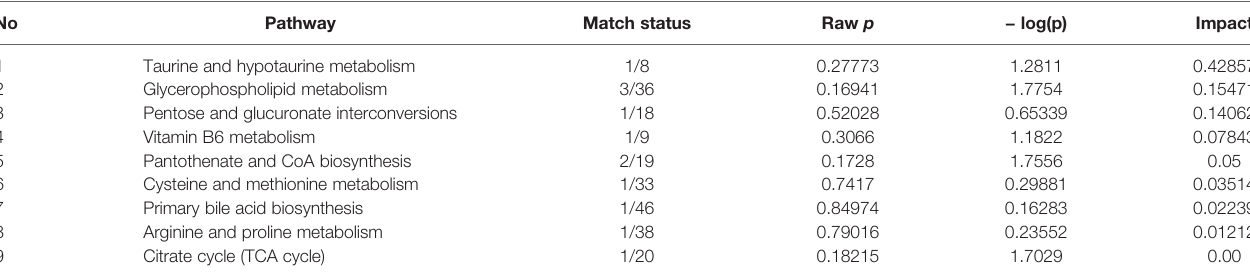
TABLE 4 | Results of integrating enrichment analysis of biomarkers with MetaboAnalyst 4.0.